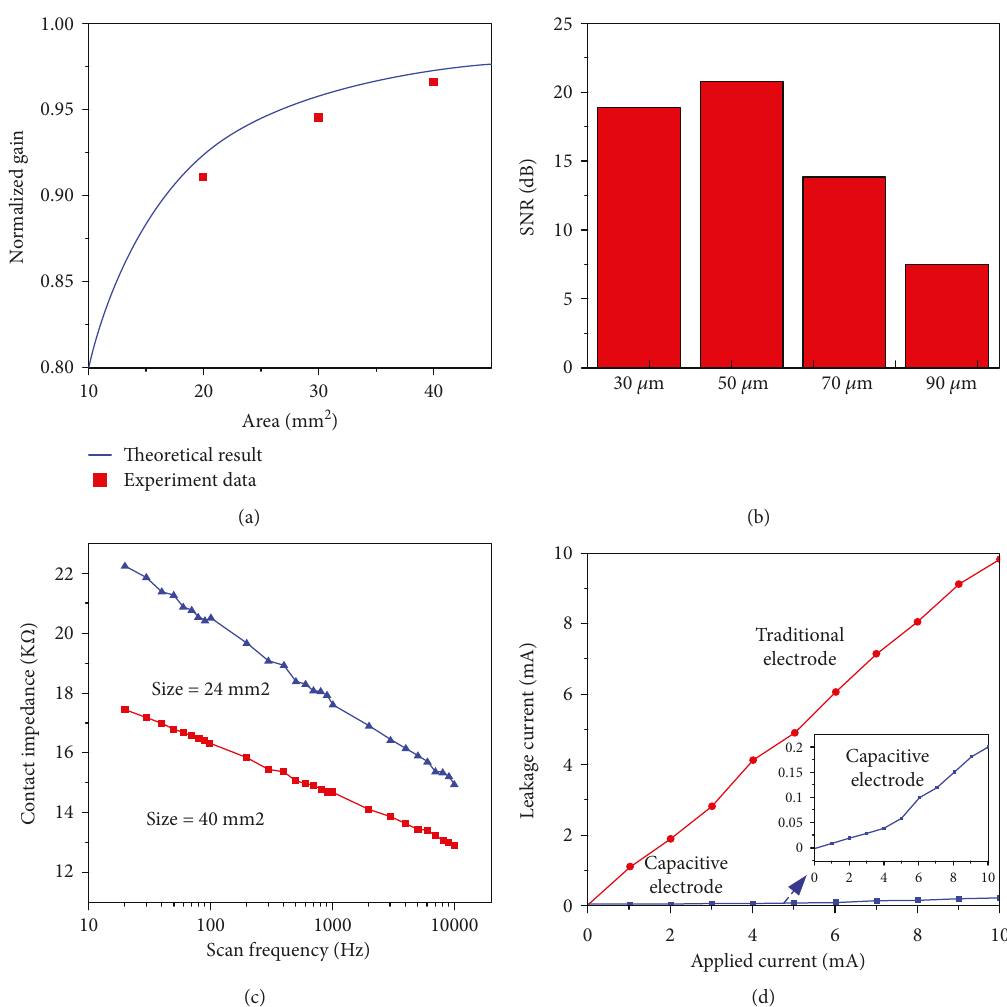
Figure 10: Electrical performance of the capacitive biological electrode. (a) The experimental and theoretical results between the output gain and the area. (b) SNR from the capacitive biological electrode with di ff erent line widths. (c) Contact impedance versus with the scanning frequency. (d) The leakage current at the skin/electrode